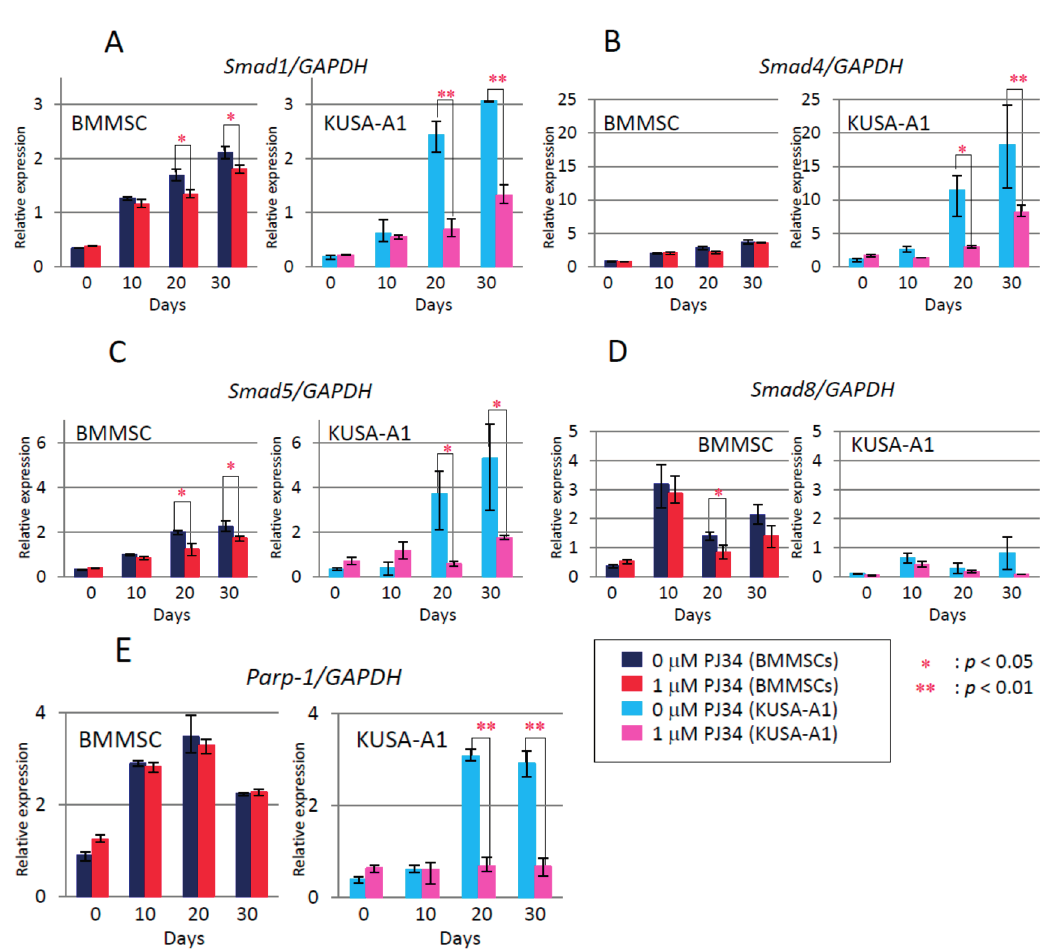
Figure 8. The effect of PJ34 on induction level of mRNA for transcription factors during osteogenic differentiation was also analyzed. Factors analyzed were Smad1 ( A ); Smad4 ( B ); Smad5 ( C ); and Smad 8 ( D ); Expression level of Parp-1 was also analyzed ( E ). Values are expressed as mean ± SEM. * p < 0.05, ** p <